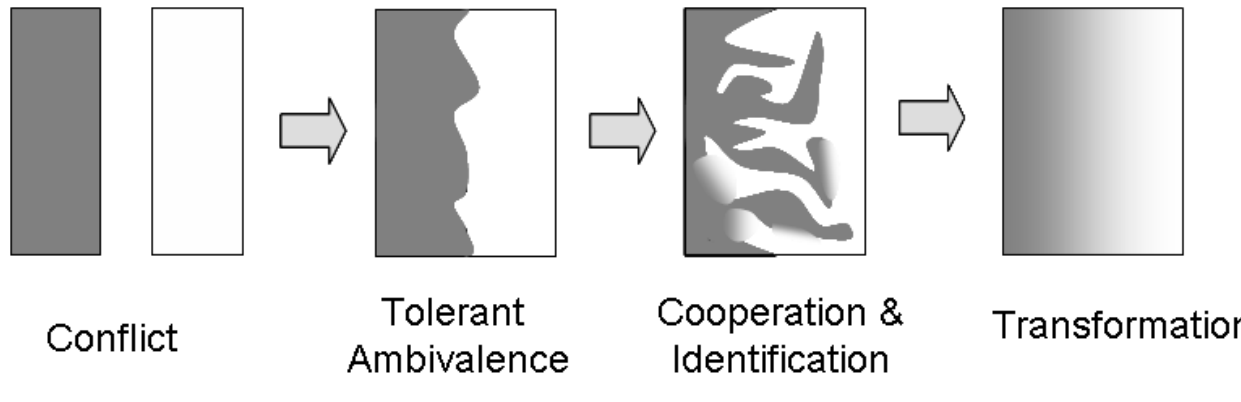
Fig. 1. A schematic of the continuum of intersecting knowledge claims. Four specific scenarios are identified, but most interdisciplinary research or situations will be situated between these discrete